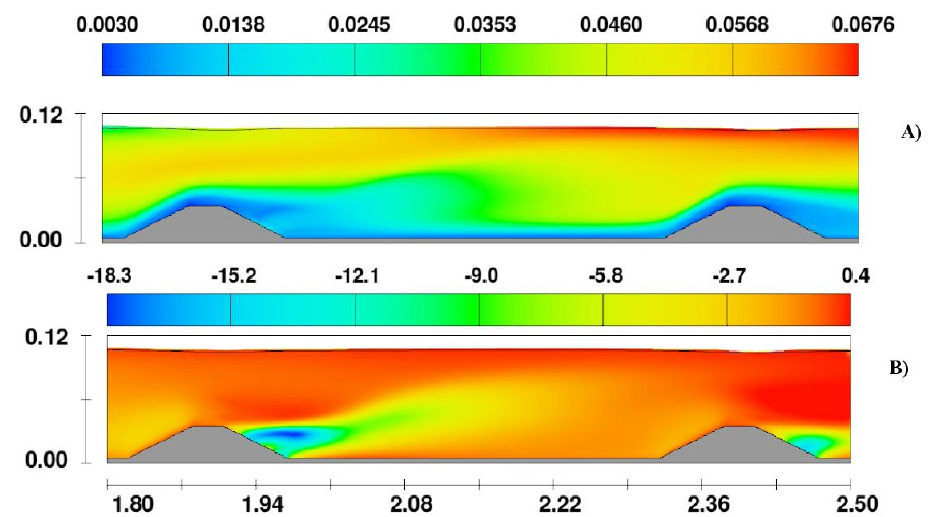
Figure 13. LES output in the XZ plane of the EZ (dim in meters) along the experimental zone of the ( A ) turbulent length scale (m) and ( B ) upstream vorticity (m − 1